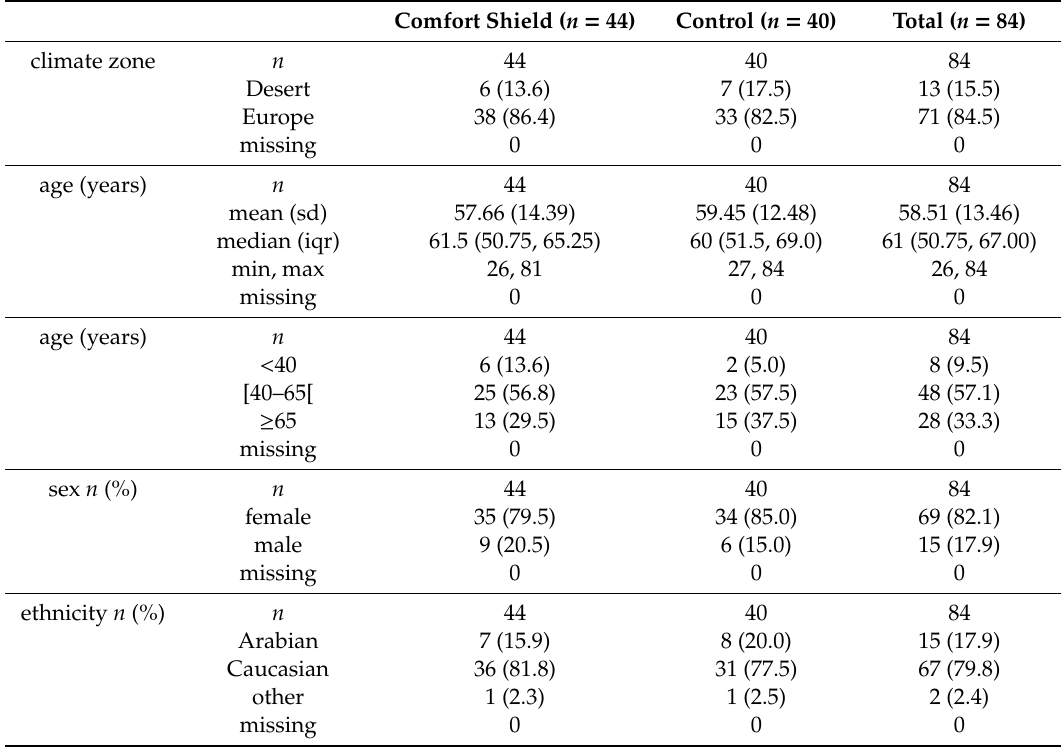
Table 2. Climate zone and socio-demographic characteristics according to the treatment arm– per-protocol set (PPS) population ( n =